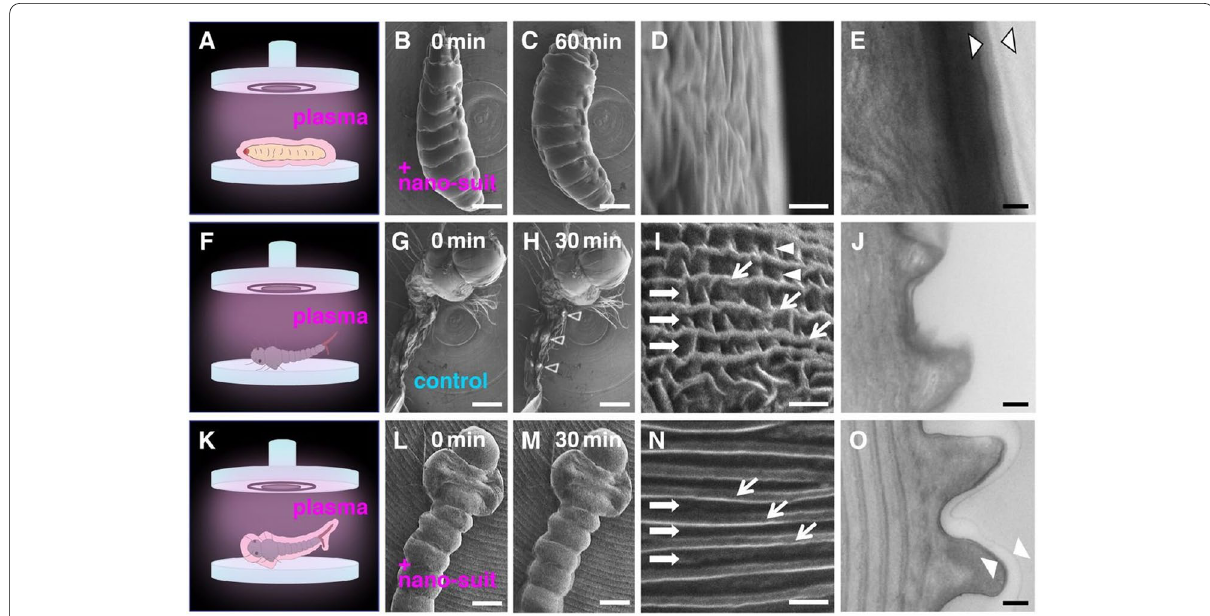
Fig. 2 Insect larvae. A – E Drosophila larva irradiated with plasma for 3 min observed using SEM for 60 min. A Schematic drawing. B to D SEM images. E TEM image. Arrowhead extra surface layer. F – J Mosquito Culex pipiens molestus larva (no extracellular substances) irradiated with = plasma for 3 min observed using SEM for 30 min. F Schematic drawing. G – I SEM images. Arrowhead ( H and I ) Arrows ( I ) furrows with wrinkles. J TEM image. K – O Mosquito larva irradiated with electron beam and treated with plasma-irradiated Tween 20. K = Schematic drawing. L – N SEM images. Arrows (N)